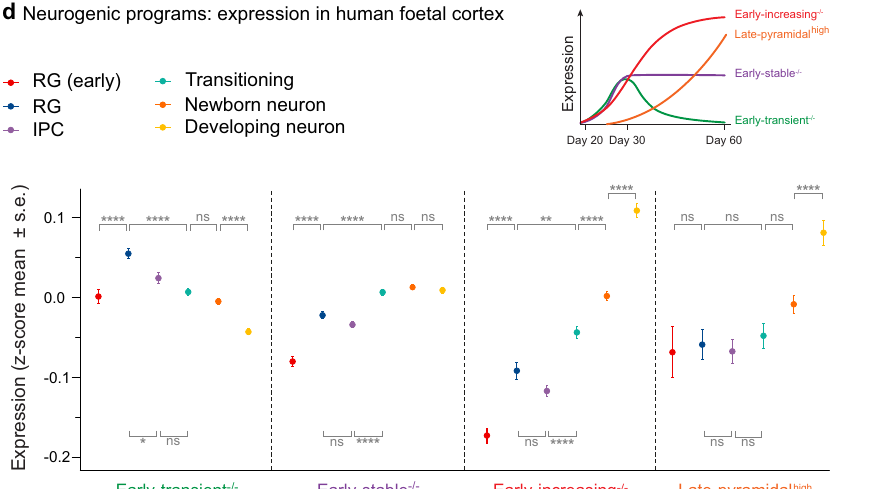
solution of 5% donkey serum (Biosera) in 0.3% Triton-X-100 (Sigma) in PBS (0.3% PBST). Primary antibodies, used at an assay dependent concentration (see ‘ Antibody concentration ’ ), were diluted in blocking solution and incubated with cells overnight at 4°C. Following removal of primary antibody solution and 3 PBS washes, cells were incubated in the dark for 2h at room temperature with appropriate Alexa Fluor secondary antibodies (Thermo Fisher Scienti fi c) diluted 1:500 with blocking solution. After an additional 2 PBS washes cells were counterstained with DAPI nucleic acid stain (Thermo Fisher Scienti fi c), diluted 1:1000 with PBS, for 5mins at room